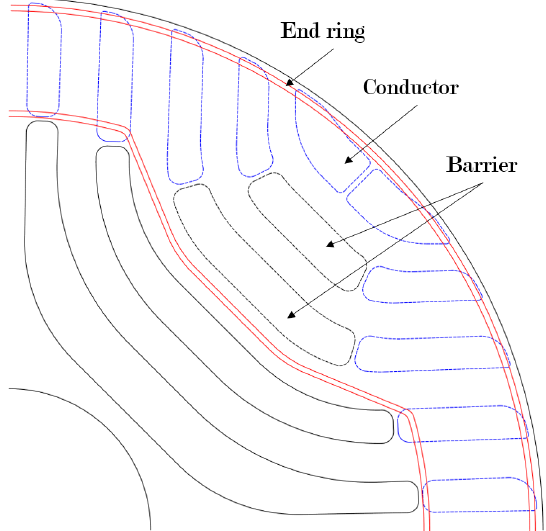
Figure 10. Rotor geometry of the second